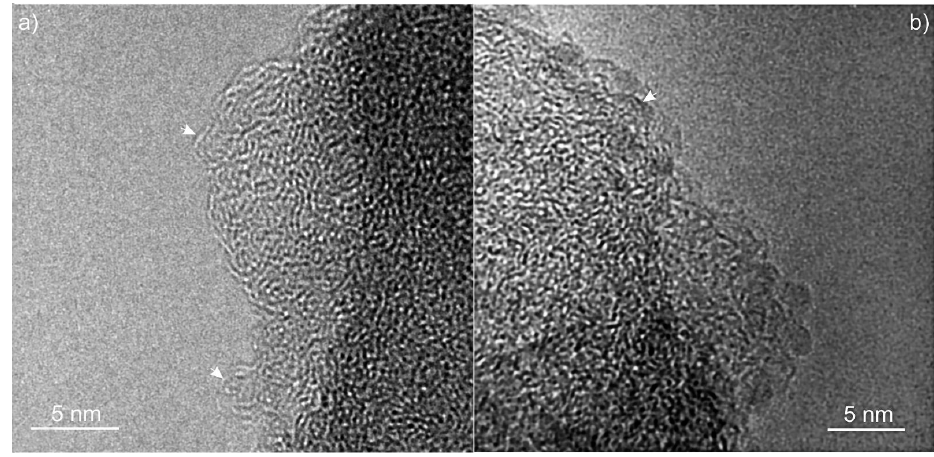
Figure 6. HRTEM images of ( a ) Char1.5 and ( b ) Char2.5. Raman spectra of Char1.5 and Char2.5, obtained employing three laser lines (785 nm, 514 nm, and 442 nm), are illustrated in Figure 7.